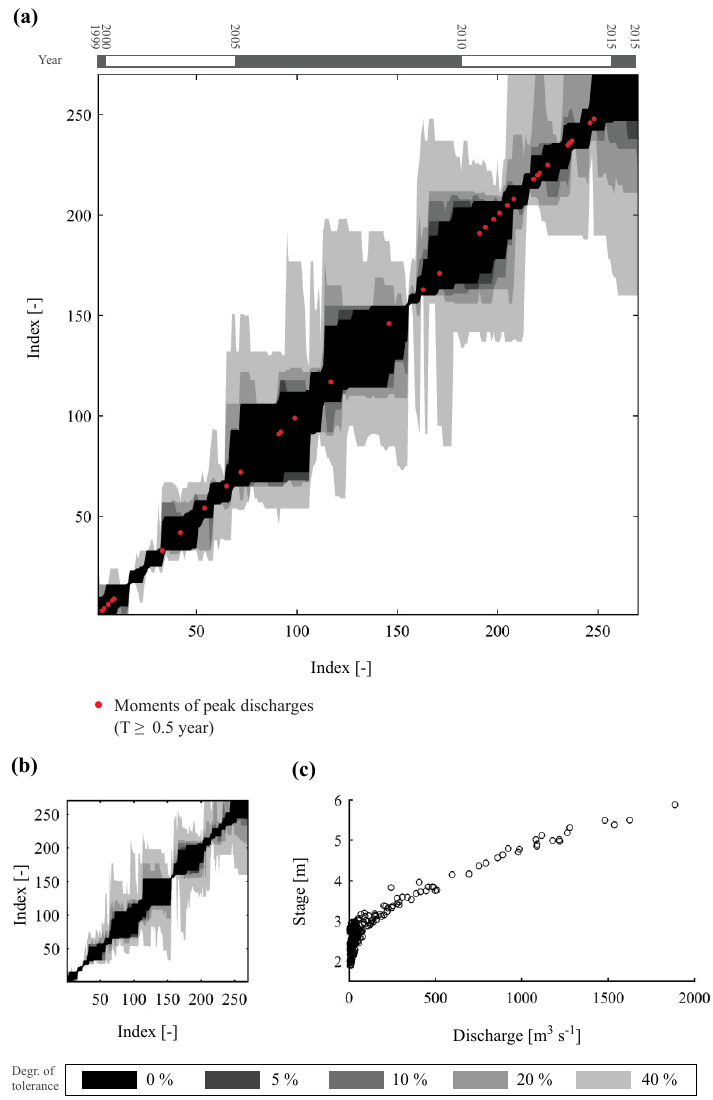
Figure 7. Combined BReach t_2s plot (all data) for Barnett’s Bank using uncertainty boundaries from (a) McMillan et al. (2010) and (b) Coxon et al. (2015). In all subplots, for each index on the x axis the gray area indicates the span between the index of the maximum left reach (under the bisector) and the maximum right reach (above the bisector). Each gray tint represents a different degree of tolerance (i.e., percentage of data points allowed to have nonacceptable model results). (c) Stage–discharge data for Barnett’s